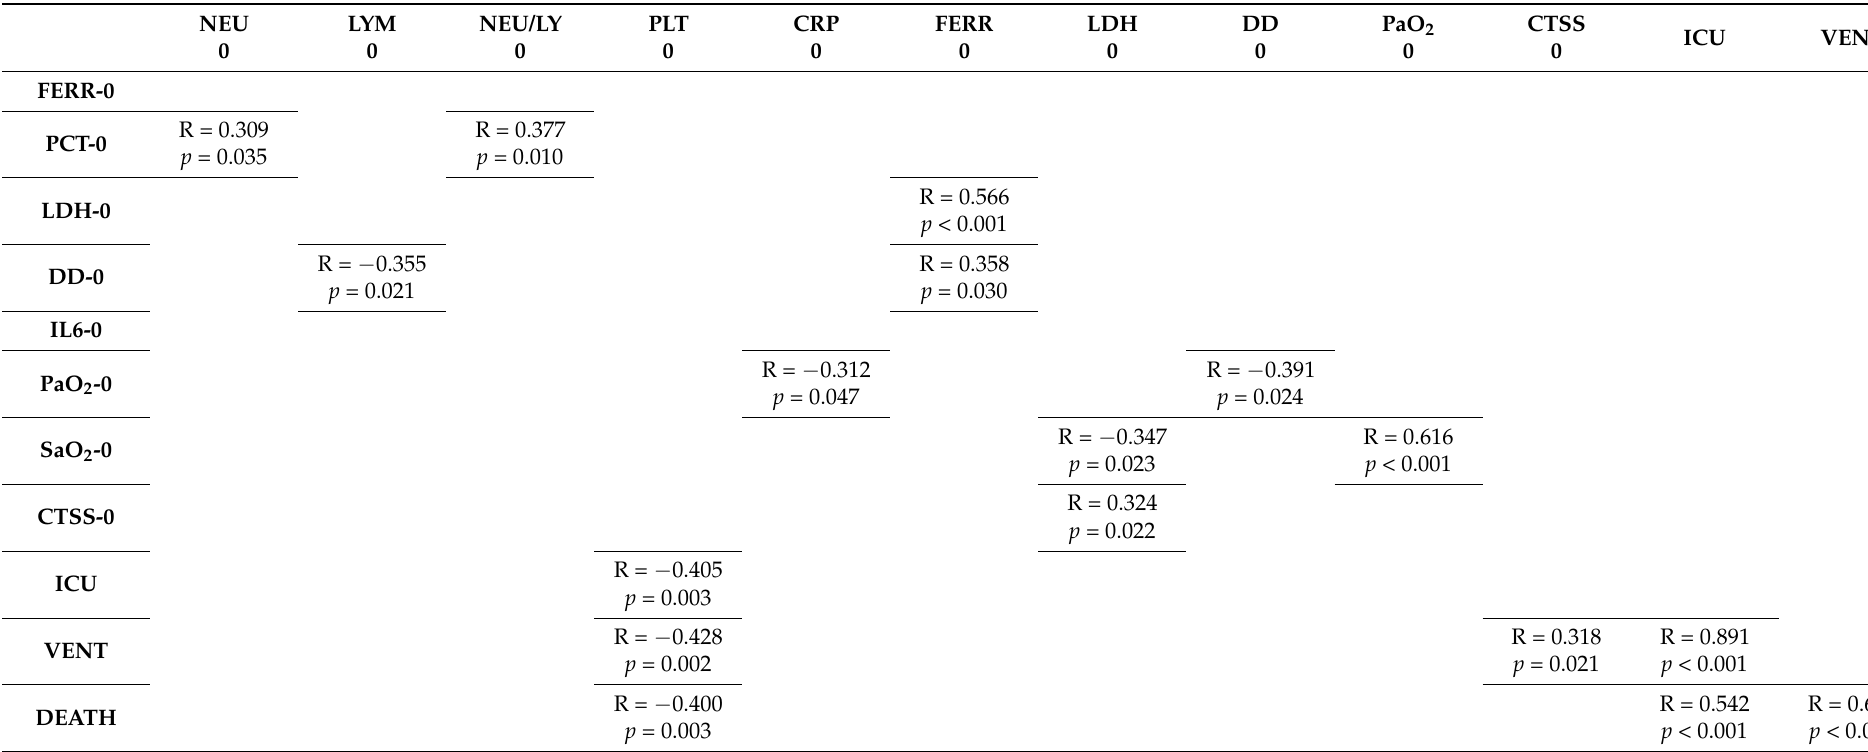
Table 4. Significant correlations between various parameters in the control